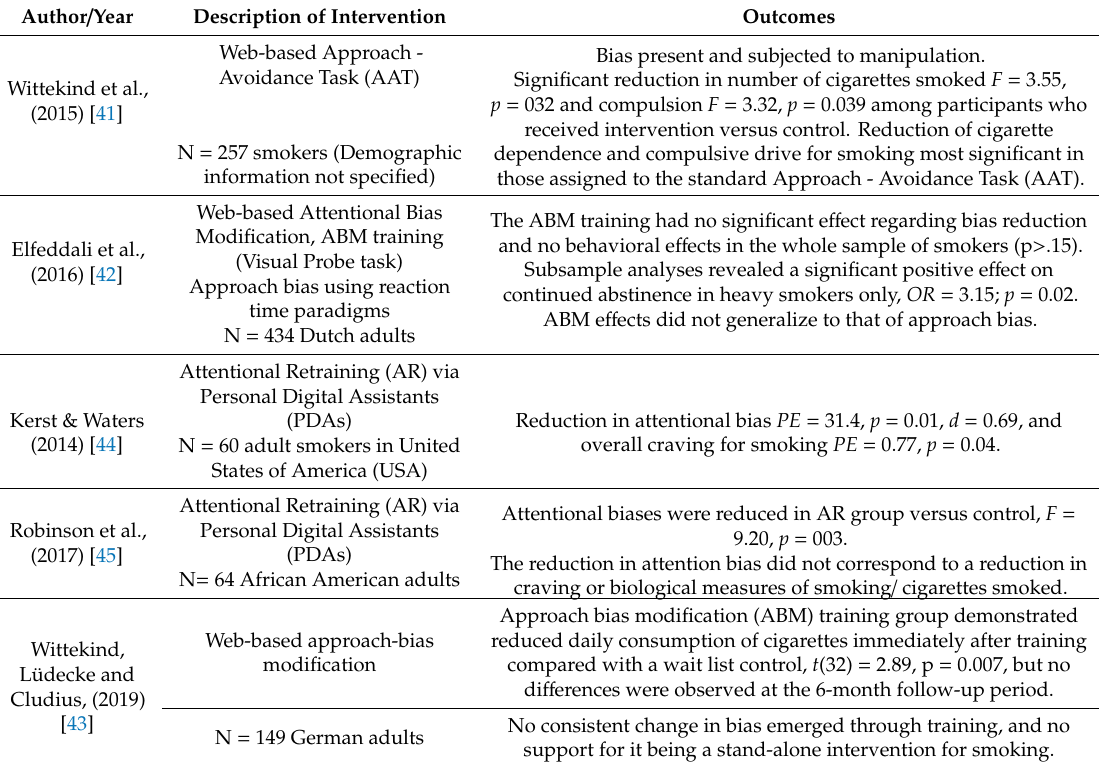
Figure 1. PRISMA (Preferred Reporting Items for Systematic Reviews and Meta Analyses) flow diagram. Table 1. Summary of